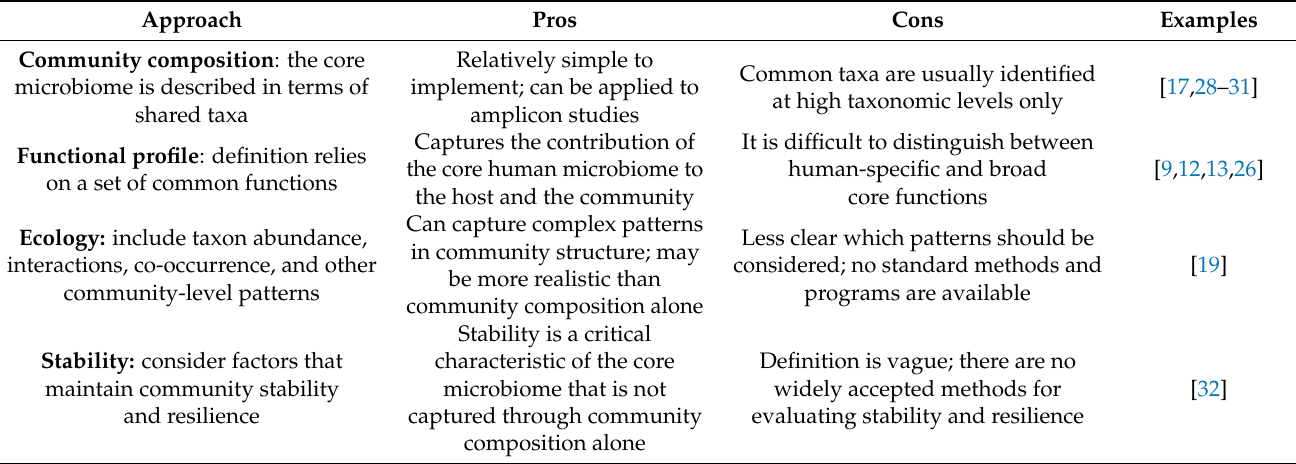
Table 1. Approaches for defining the core human